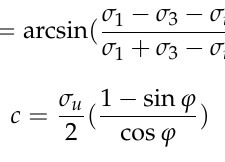
Figure 3. Equipment of triaxial tests.